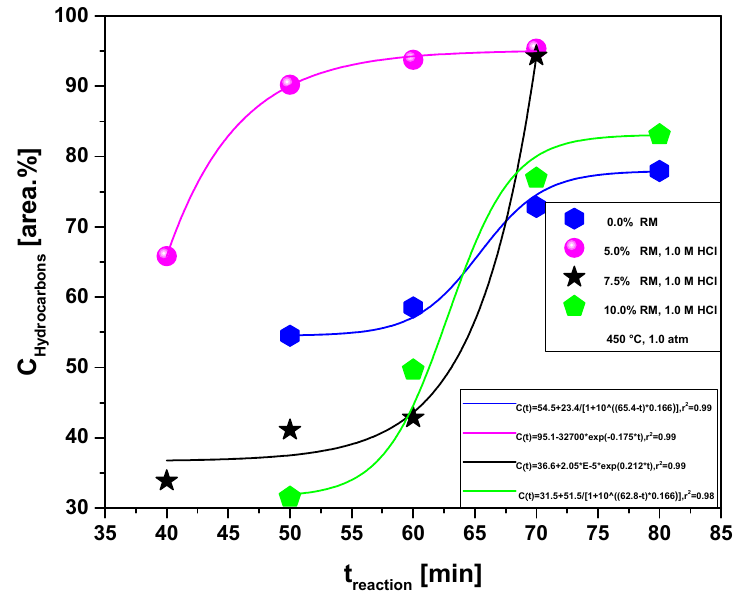
Figure 18. Effect of reaction time on the content of hydrocarbons by the upgrading of residual fat pyrolysis vapors at 450 ◦ C, 1.0 atmosphere, 0.0%, 5.0%, 7.5%, and 10.0% (wt.) red mud pellets activated with 1.0 M HCl, using a catalyst fixed bed reactor, using a semi-pilot scale two-stage reactor of 2.0 L.